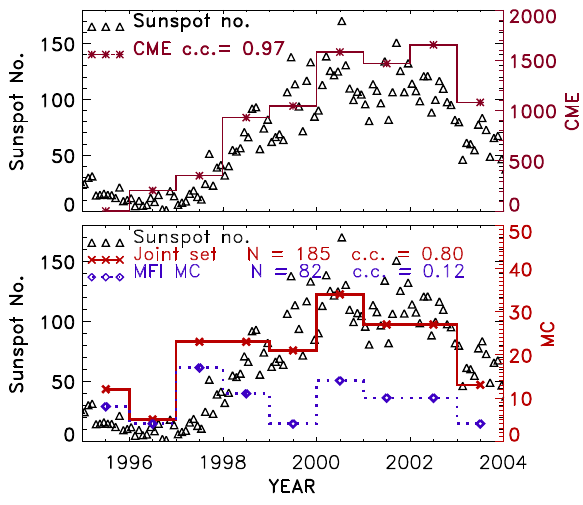
Fig. 14. (Top) Monthly sunspot number (SSN, triangles) and num- ber of CMEs (***) (Gopalswamy et al., 1998) vs. time over the period of 1995 through 2003; the CMEs are yearly-averaged. The CMEs very well track the SSNs, as expected with a linear correla- tion coefficient, c.c.=0.97. (Bottom) SSN (triangles) vs. time, and yearly averaged occurrence of WIND MCs (dots-diamonds) and joint set (MC+MCL) of events (solid-xs) vs. time for the same time period; MCL refers to magnetic cloud-like structures that are deter- mined by a program developed by Lepping et al. (2005) (see Sec- tions 2.1 and 6.0). In this panel it is evident that the joint set much better correlates with SSN than with the (MFI) MC set alone. In fact, the linear correlation coefficient for WIND MCs vs. SSN was only c.c.=0.12, but for MCLs vs. SSN it was